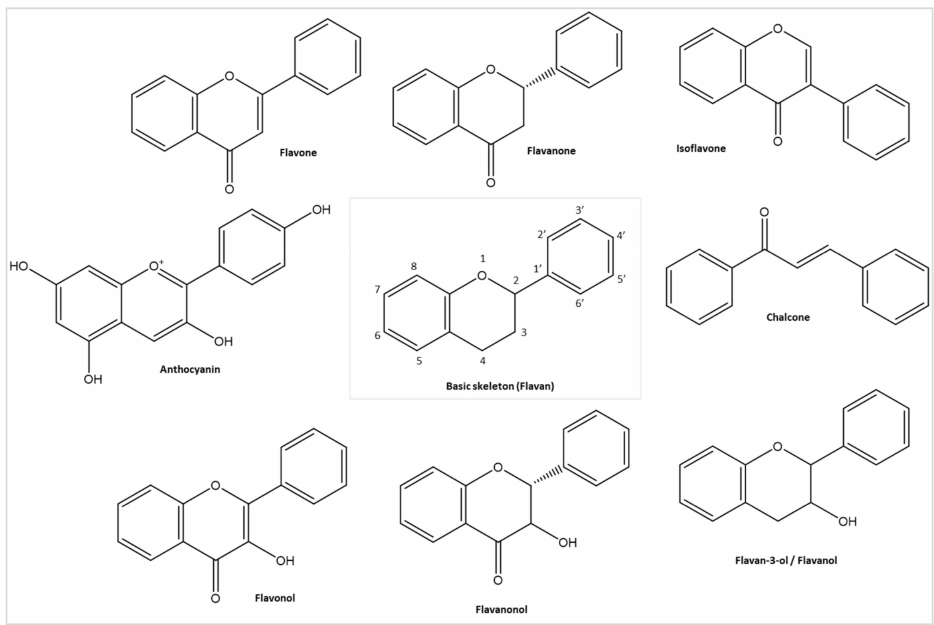
Figure 7. Basic structure of flavonoids (Flavan) and its different classes; image made using Chem- Draw (https://perkinelmerinformatics.com/products/research/chemdraw/, accessed on 1 Septem- ber